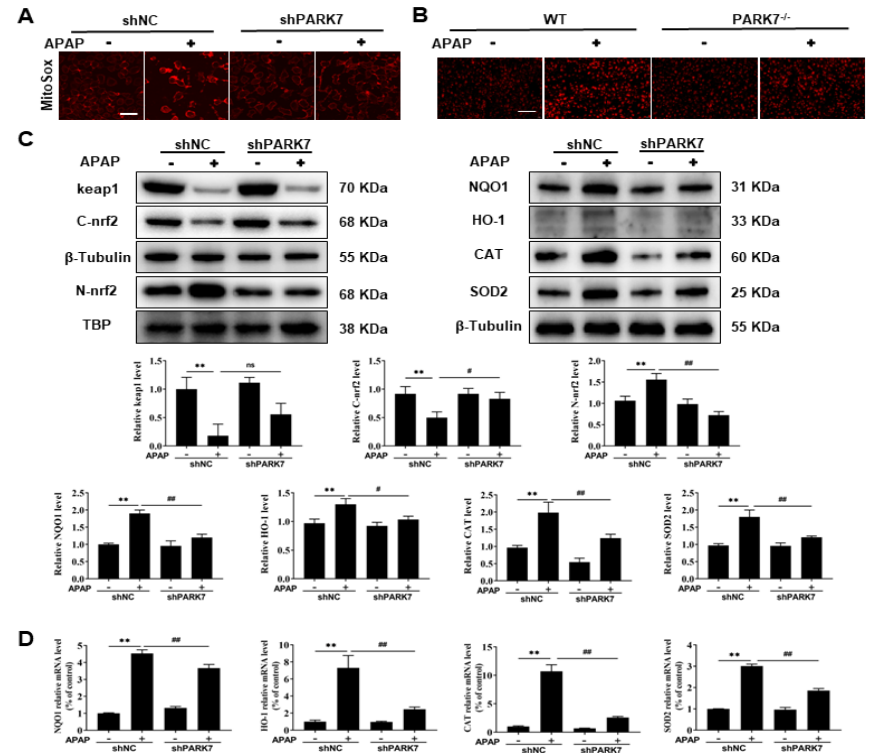
Figure 5. The protective effect of PARK7 silencing was not due to antioxidant activity. ( A ) Changes in mitochondrial ROS in L02 cells treated with APAP with or without PARK7 silencing, N = 3. ( B ) Changes in mitochondrial ROS in liver tissue of mice with or without APAP intervention with PARK7 knockdown, N = 3. ( C ) WB and statistical analysis of Keap1, Nrf2, NQO1, HO-1, SOD2 and CAT proteins under APAP intervention with or without PARK7 silencing, N = 3. ( D ) Changes in mRNA levels of NQO1, HO-1, SOD2 and CAT under APAP intervention with or without PARK7 silencing, N = 3. ** p < 0.01 vs. ShNC group, # p < 0.05 vs. ShNC+APAP group, ## p < 0.01 vs. ShNC+APAP group. C represents the cytoplasm and N represents the